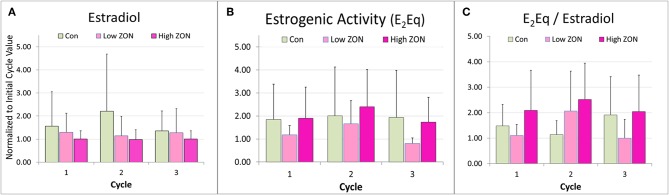
Peak (A) estradiol, (B) peak estrogenic activity, and (C) the ratio of E2Eq/E2 of Mares on ZON treatments. E2 and E2Eq were normalized to the mare's first cycle values. E2Eq/E2 was calculated as the ratio of the normalized values of E2Eq and E2 for each mare. Means ± S.D. are shown for three cycles.